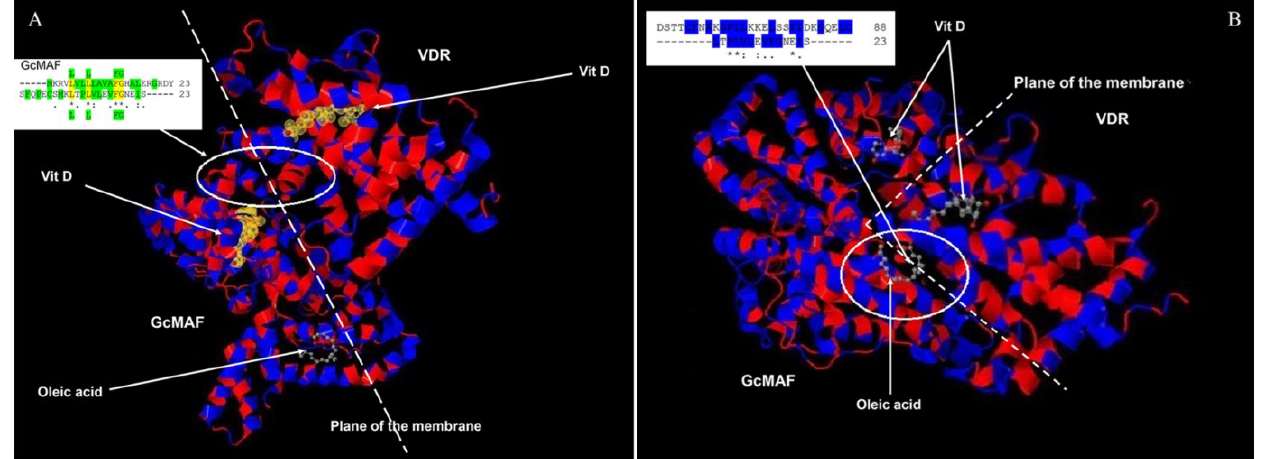
Figure 4. Amino acid alignments and three-dimensional protein structures of vitamin D-binding protein/GcMAF and VDR. ( A ) 23 hydrophobic amino acids of VDR (on the right), located at the inner part of the plasma membrane (dotted line), interact with 23 hydrophobic amino acids of the GcMAF (on the left of the Figure) located at the external part of the plasma membrane. In the insert the hydrophobic amino acids are highlighted in green and the four hydrophobic amino acids that are identical (L L FG) are highlighted in yellow and in green above and under the alignment. Vitamin D indicates 1,25(OH)(2)D3. ( B ) 23 hydrophobic amino acids of the VDR interact with a stretch of hydrophobic amino acids of the unsaturated fatty acid binding site of GcMAF. In the insert, eight amino acids with similar functional valence in a long stretch of hydrophobic amino acids highlighted in